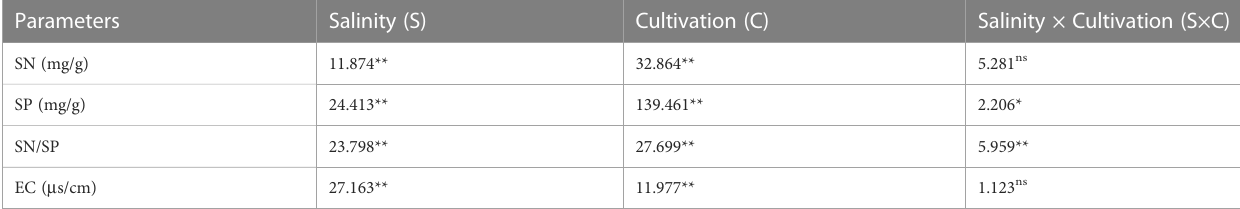
TABLE 2 Results of two-way ANOVA for the effects of salinity (S), cultivation (C), and their interactions (S × C) on soil properties. Parameters Salinity